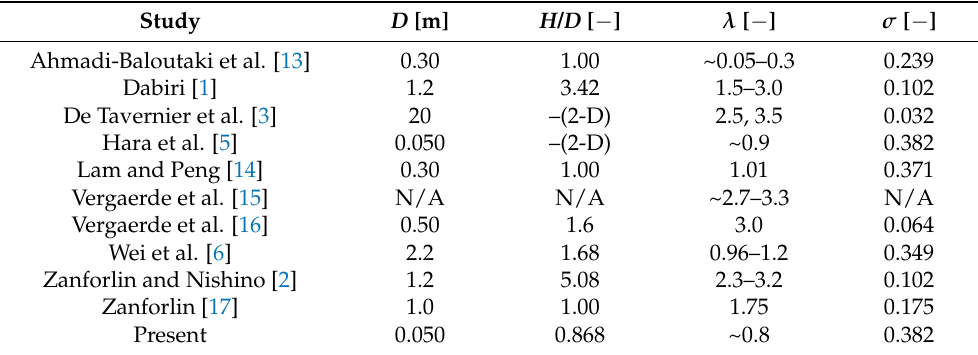
Table 1. Comparison of VAWT parameters. D is the rotor diameter, H / D is the aspect ratio, λ = R ω / V is the tip speed ratio and σ = Bc /( π D ) is the solidity (not in Bc / D as in, e.g., De Tavernier et al. [3]). N/A means not available.